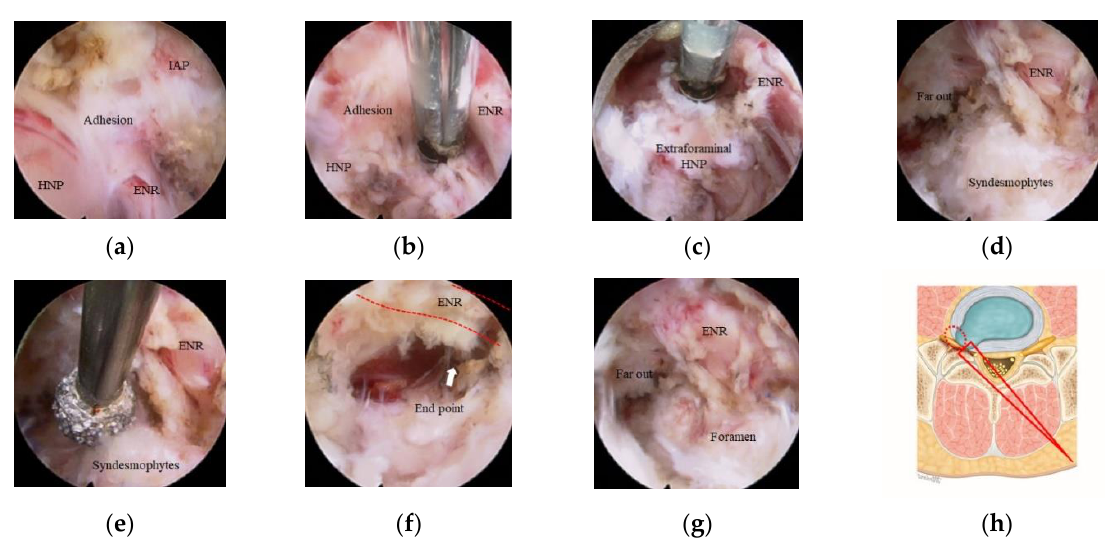
Figure 3. Intraoperative images during foraminal and extraforaminal decompression. ( a ) The compressed L5 exiting nerve root (ENR), herniated nucleus pulposus (HNP), and surrounding severe tissue adhesion were found. ( b ) Secure dissection along the ENR and foraminal discectomy were performed. ( c ) Extraforaminal discectomy was done without ENR retraction via an inferior-ventral foraminal tunnel formed after foraminal discectomy. ( d ) Decompression was done till the far-out region, but syndesmophytes were still compressing the ENR. ( e ) Syndesmophytes were removed by drilling along the ENR. ( f ) The endpoint (white arrow) is the far-out area where the exiting root began to curve downward with natural angulation. ( g ) Adequate decompression of the ENR in the foraminal and extraforaminal region was confirmed under endoscopic visualization. ( h ) The endoscopic trajectory (long red triangle) and work area (red dotted circle) of the were demonstrated on the axial illustration.